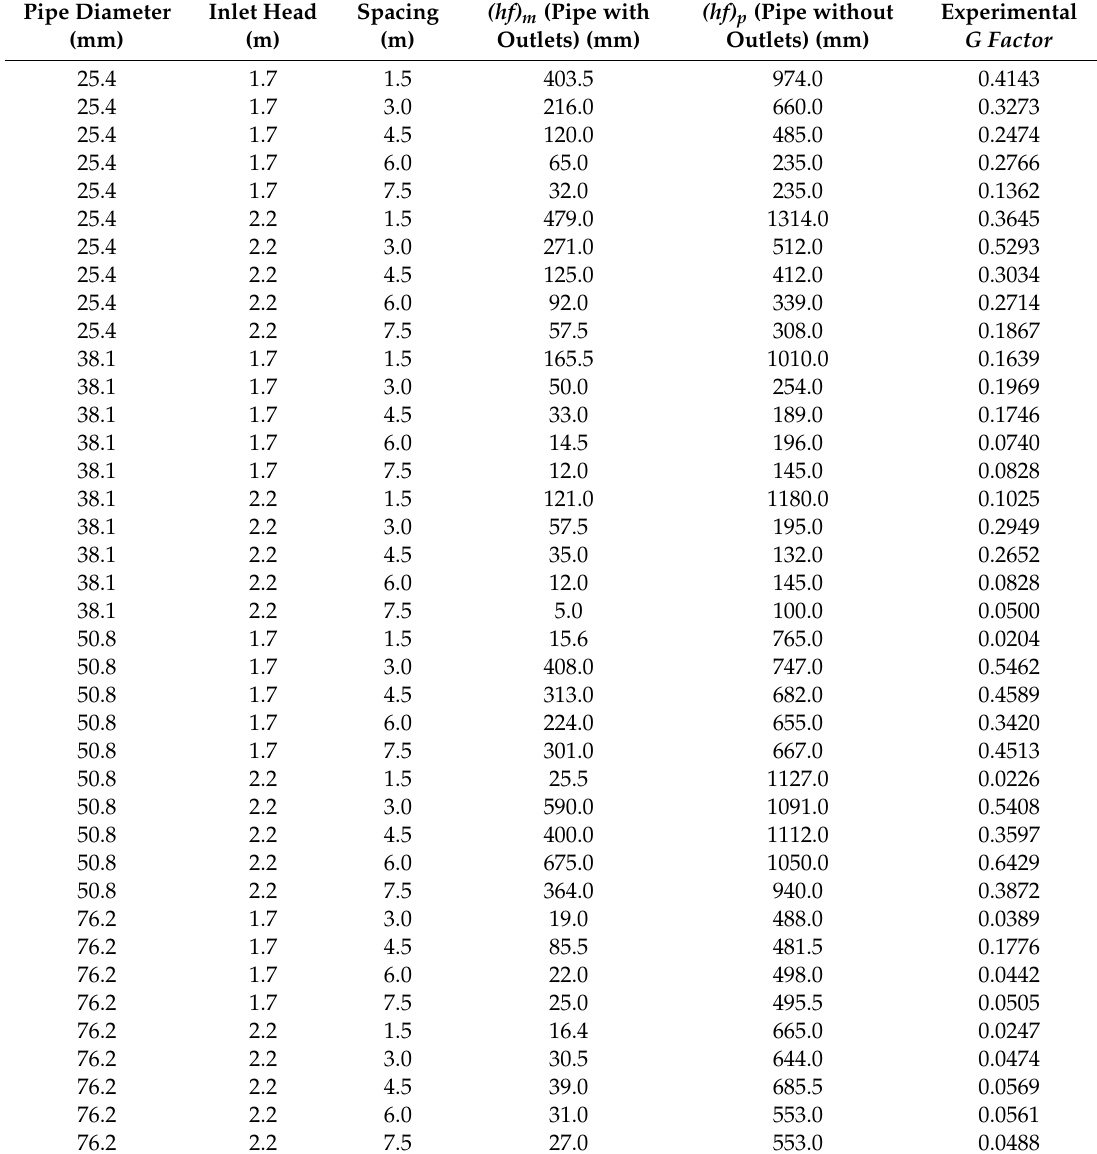
Table 1. Calculated head loss and the G factor for a pipe with and without